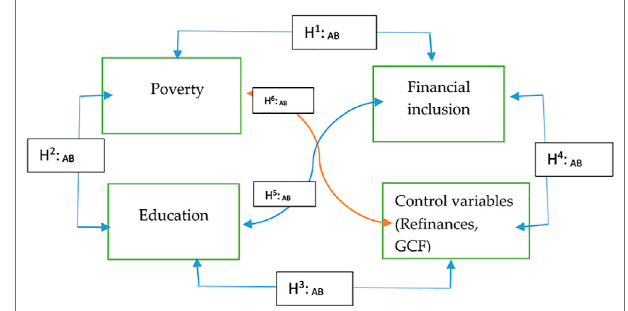
FIGURE 1 | Conceptual and hypnotized model for hypothesis testing. H 1 : AB poverty Granger causes fi nancial inclusion and vice-versa.